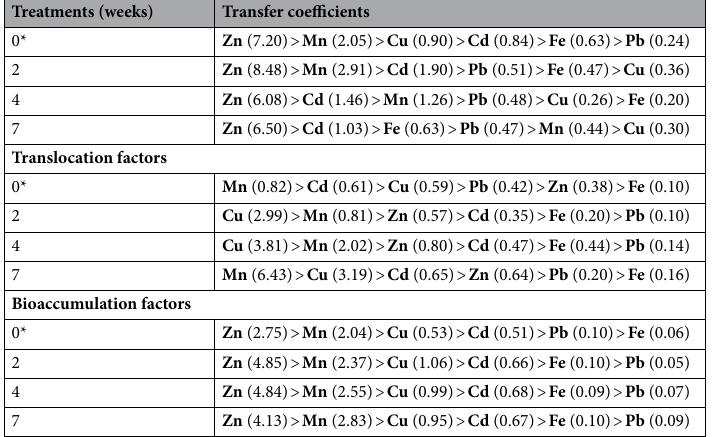
Table 5. Series of metals ordered according to decreasing transfer coefficients (TC’s), translocation factors (TF’s) and bioaccumulation factors (BAF’s) calculated for Taraxacum officinale cultivated in soil with thiuram supplementation. Numerical data are in parenthesis. *Control data are indicated with the null contact time, they refer to untreated plants and were collected just before the thiuram treatment.